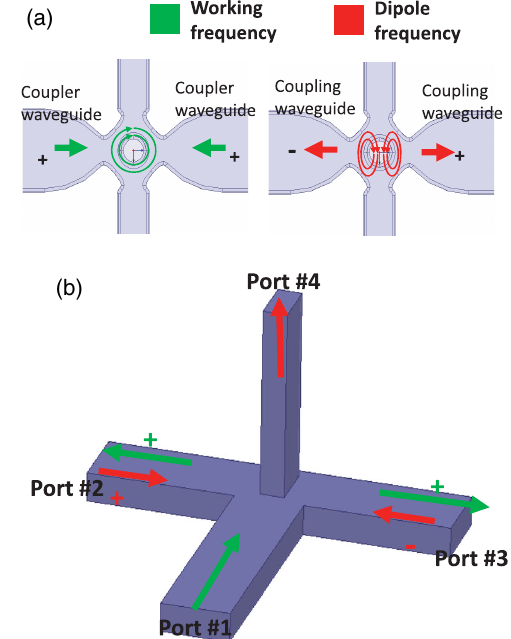
FIG. 28. Bandwidth of (a) the working frequency and (b) the major dipole frequency in the Magic-T design.